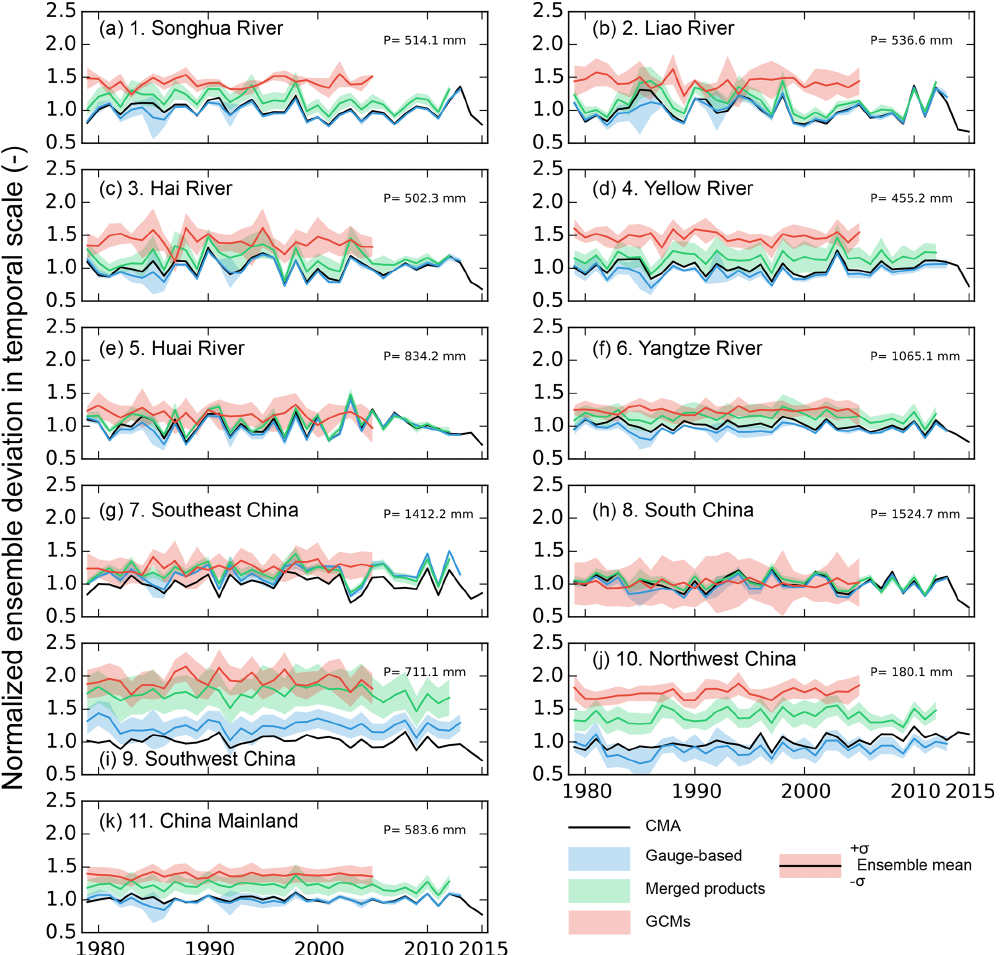
Figure 6. Temporal evolution of the model uncertainty. The uncertainty is expressed as the normalized ensemble deviation of annual precip- itation across ensemble datasets in each precipitation group for specific subregions. The value on the top right of each panel is the annual regional precipitation estimated in the CMA dataset (1979–2015). The annual precipitation is normalized as the ratio to the CMA long-term annual precipitation. The solid curve represents the ensemble mean of precipitation in each precipitation data group over the subregion. The width of the shaded area represents the standard deviation of the annual precipitation estimated from the datasets within that group for each year (divided by the annual precipitation of the corresponding group). The shaded area is equally distributed in the two sides of the ensemble mean values for the corresponding precipitation